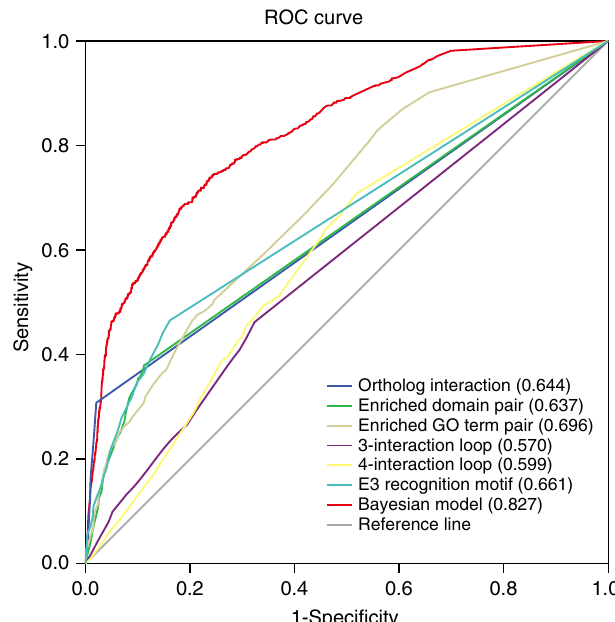
Fig. 4 ROC curves for various assessment models using fi vefold cross validations against the golden standard data sets. Each point on the ROC curves of various assessment models corresponds to sensitivity and speci fi city against a particular likelihood ratio cutoff. Different assessment models corresponding to these curves are labeled in legends. The numbers in parentheses refer to the AUC under ROC curves for each model. Sensitivity and speci fi city are computed during the fi vefold cross- validations. SPSS software is used to smooth the curves. (see text for